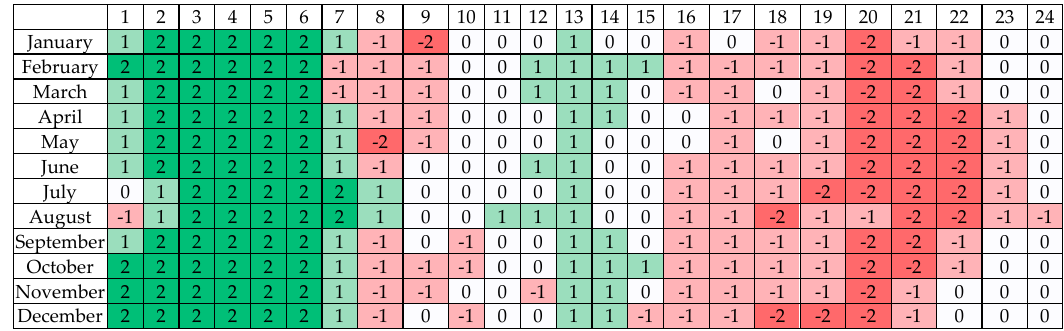
Figure 16. Strategy to optimise the load shifting: weekdays; ( − 2, Green) Strong Load reduction; ( − 1, Light Green) Weak Load reduction; (0, White) No Load variation; (1, Light Red) Weak Load increase; (2, Red) Strong Load increase.